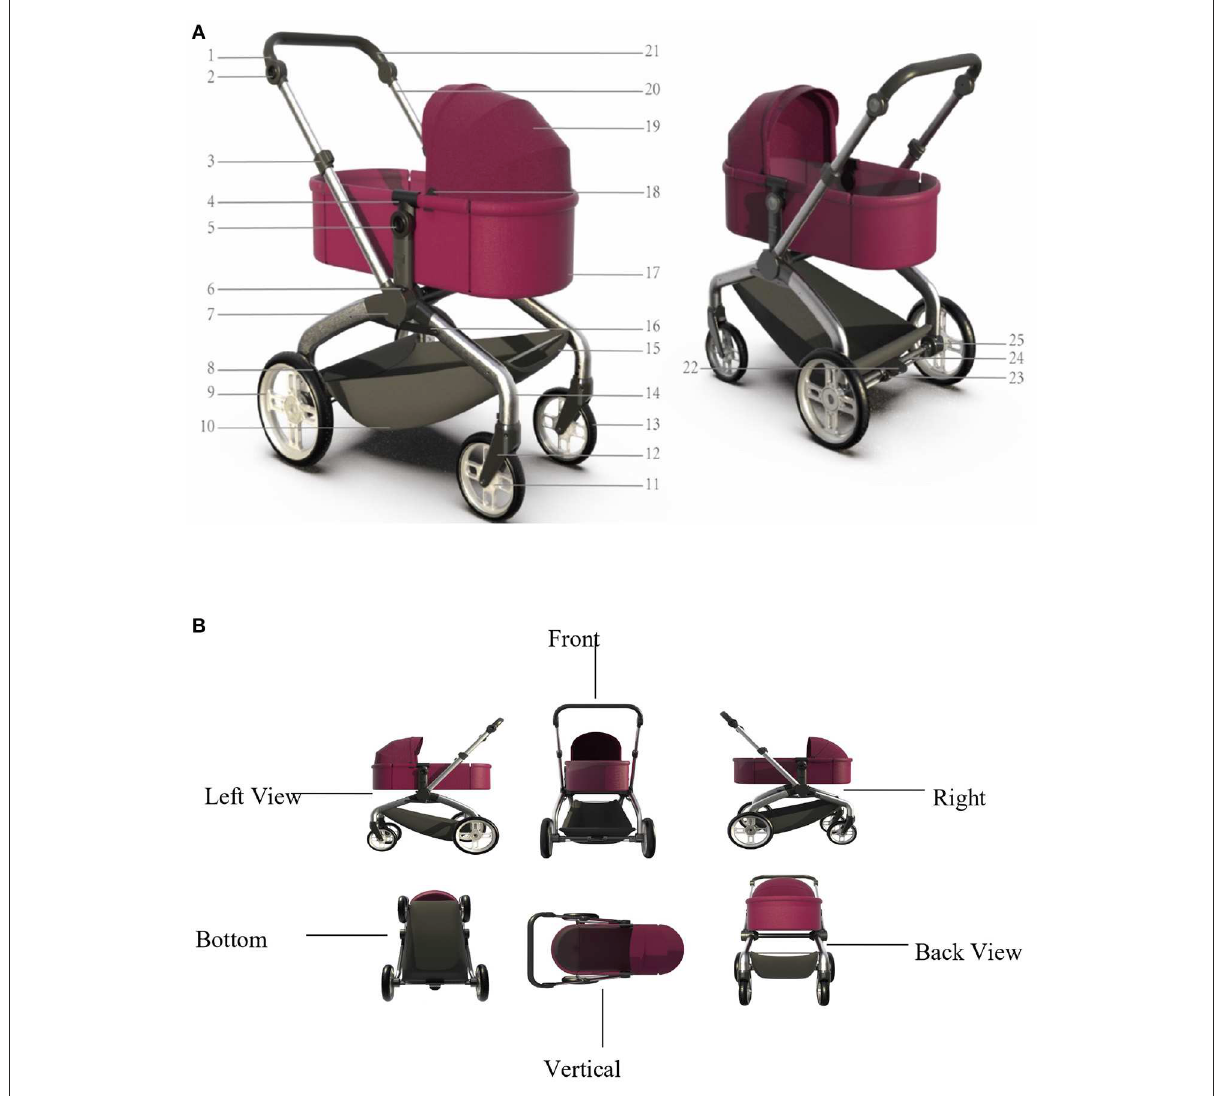
FIGURE1 (A) Novel design of the baby stroller. 1. Handle rotation connection device; 2. Rotation button; 3. Pull button; 4. Sleeping basket fixing part; 5. Sleeping basket rotation button; 6. Handle rotation button; 7. Middle connector; 8. Rear wheel outer ring; 9. Rear wheel rim; 10. Storage basket; 11. Front wheel rim; 12. Front fork; 13. Front wheel outer ring; 14. Front foot tube; 15. Storage basket; 16. Aluminum strip; 17. Sleeping basket; 18. Awning fixing buckle; 19. Awning; 20. Aluminum tube; 21. Handle; 22. Brake pedal; 23. Brake control device; 24. Brake pipe; 25. Rear wheel fixing pipe; 26. Rear wheel fixing pipe. (B) Six views of the baby